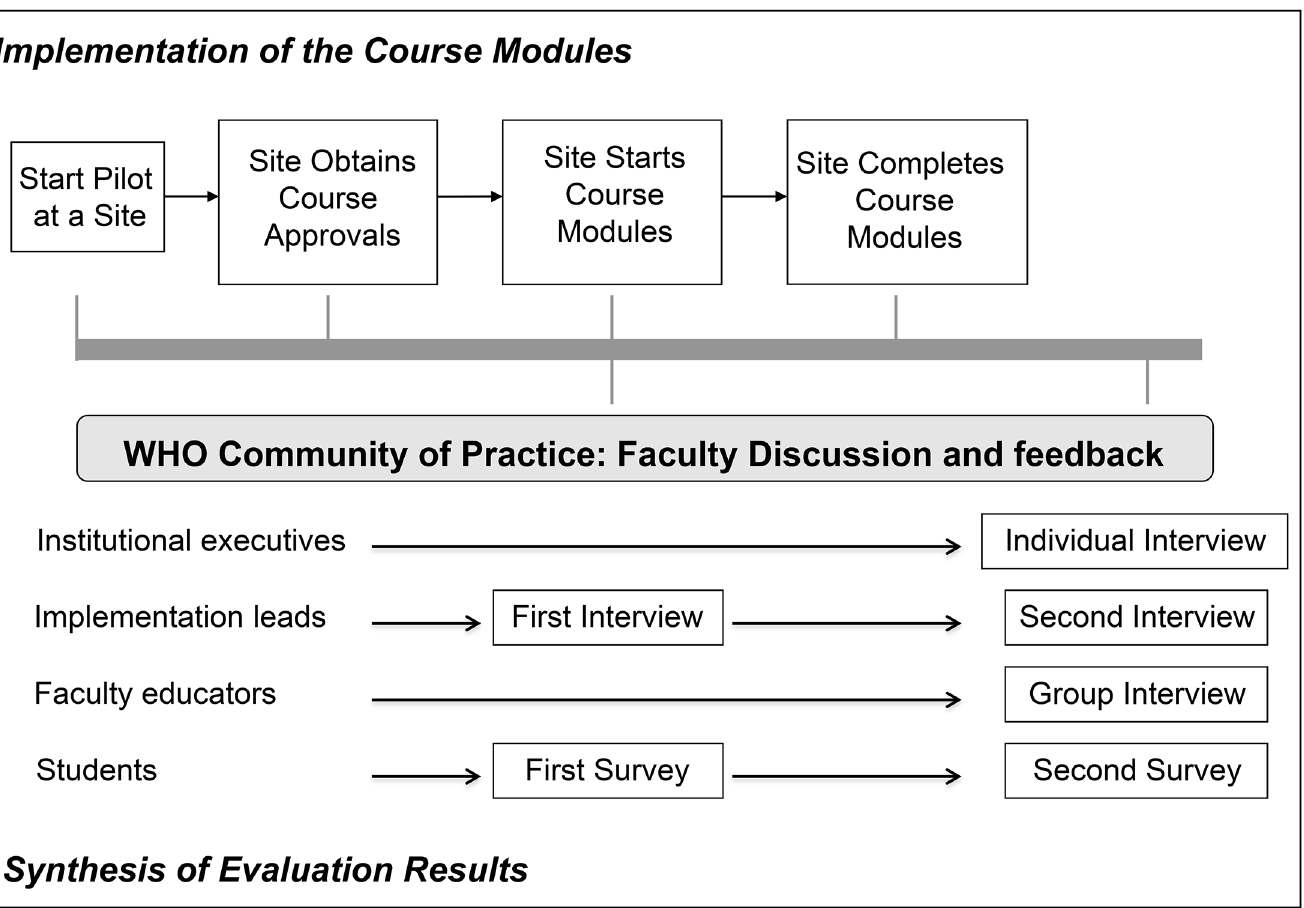
Fig 1. Diagram of the steps of the Curriculum Guide